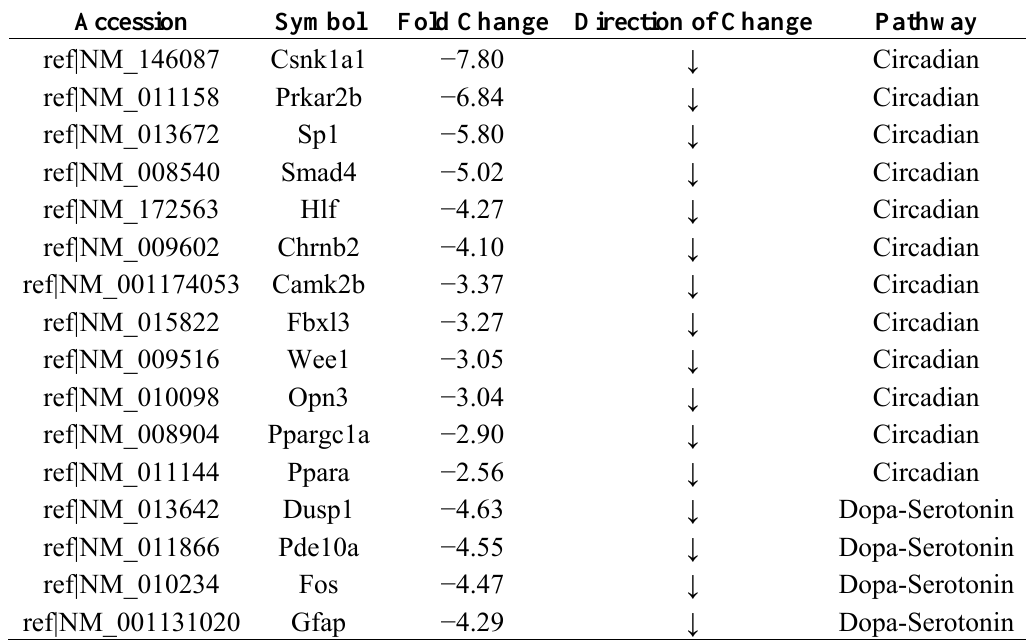
Table 2 . Neural genes altered ≥ 2.5 fold in the cerebellum of female pups from mothers having FA supplementation during gestation at 20 mg/kg in comparison to mothers at 2 mg/kg